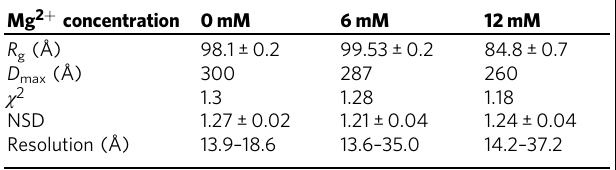
Table 1 Dependence of structural characteristics of full- length Bvht (636 nucleotides, 206 kDa) on Mg 2 +